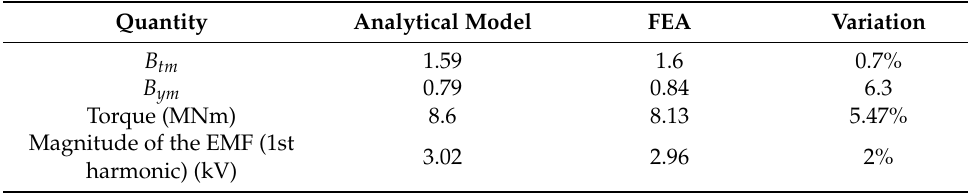
Figure 11. Flux lines and flux density at full load. Table 6. Maximum torque and EMF at 10 MW - 11 rpm.